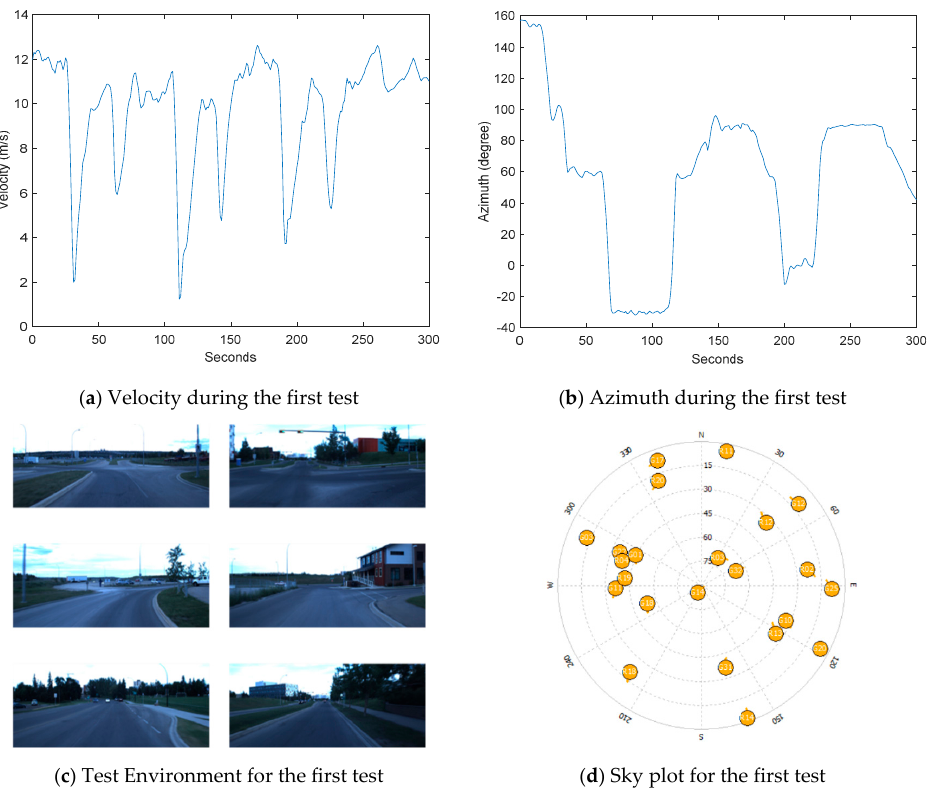
Figure 2. Velocity, azimuth, environment, and sky plot of the satellites for the first test. Sensors 2018 , 18 , x FOR PEER REVIEW